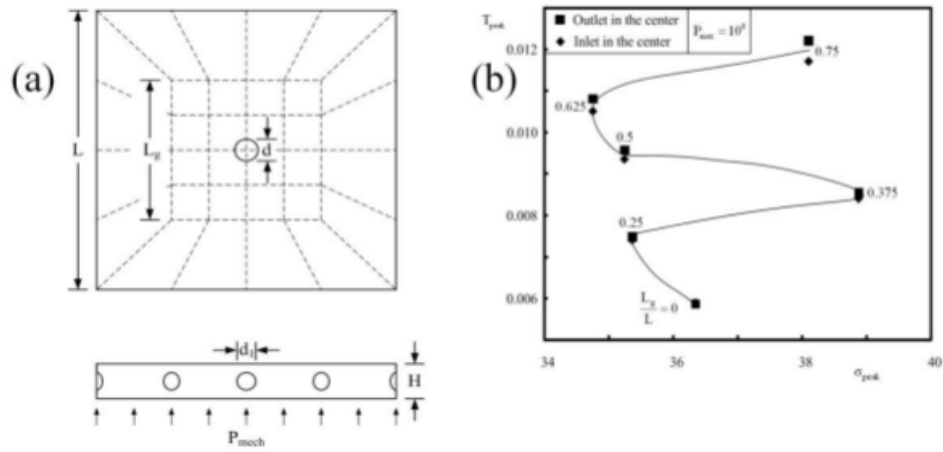
Figure 6: (a) Grid structure connected to the perimeter with radial channels, hybrid structure of a square slab. (b) Minimum peak tempera- tures relative to their peak stresses as L g / L varies.